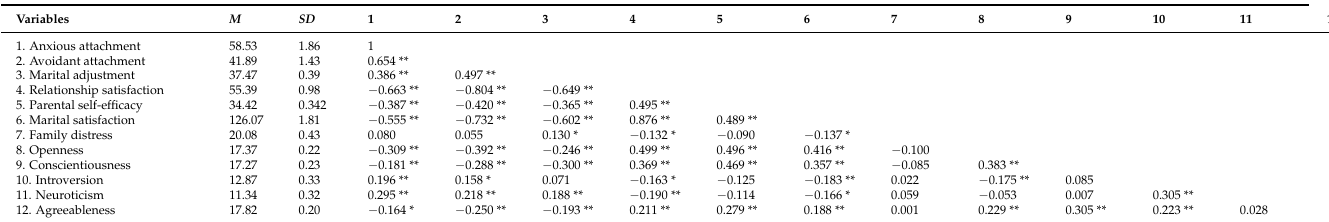
Table 1. The descriptive statistics and correlations between